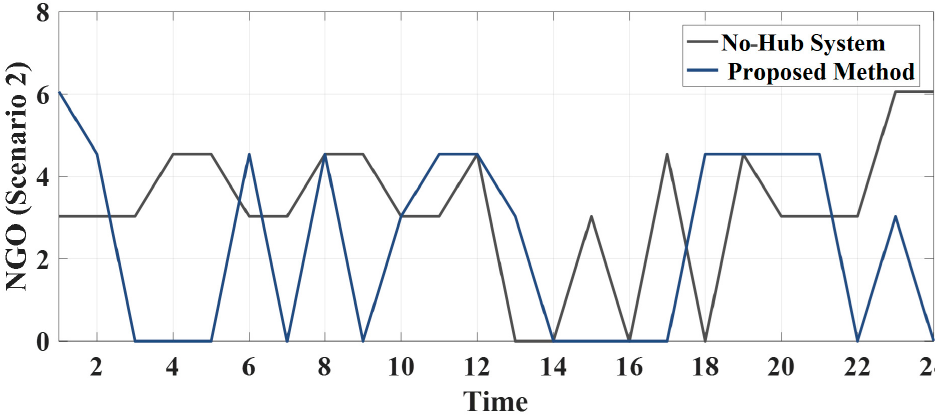
Figure 5. The vulnerability index NGO for scenario 2.